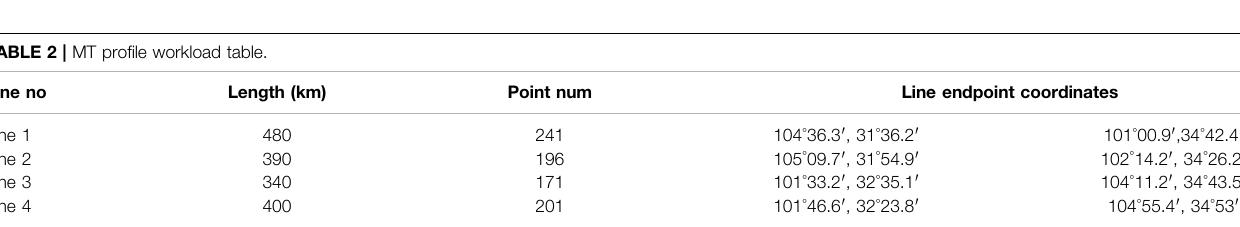
FIGURE 4 | Three-dimensional joint inversion of oblique magnetization. M (cid:2) 0.1 A/m iso-surface image ( Z axis is the number of grids, and one grid represents 2 km).